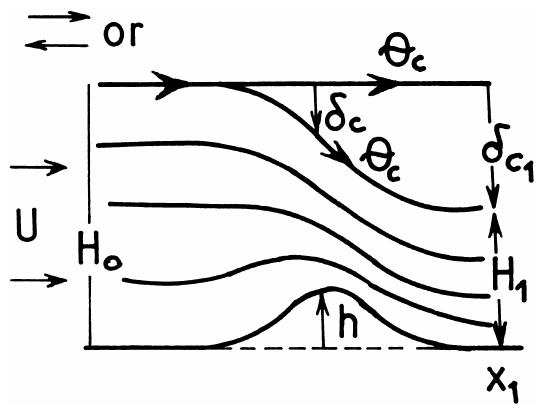
Fig. 8. Vertical profiles of potential temperature at Zagreb (ZG), Udine (UD) and Milano (MI) on 8 and 9 February 1984 at 00 UTC.